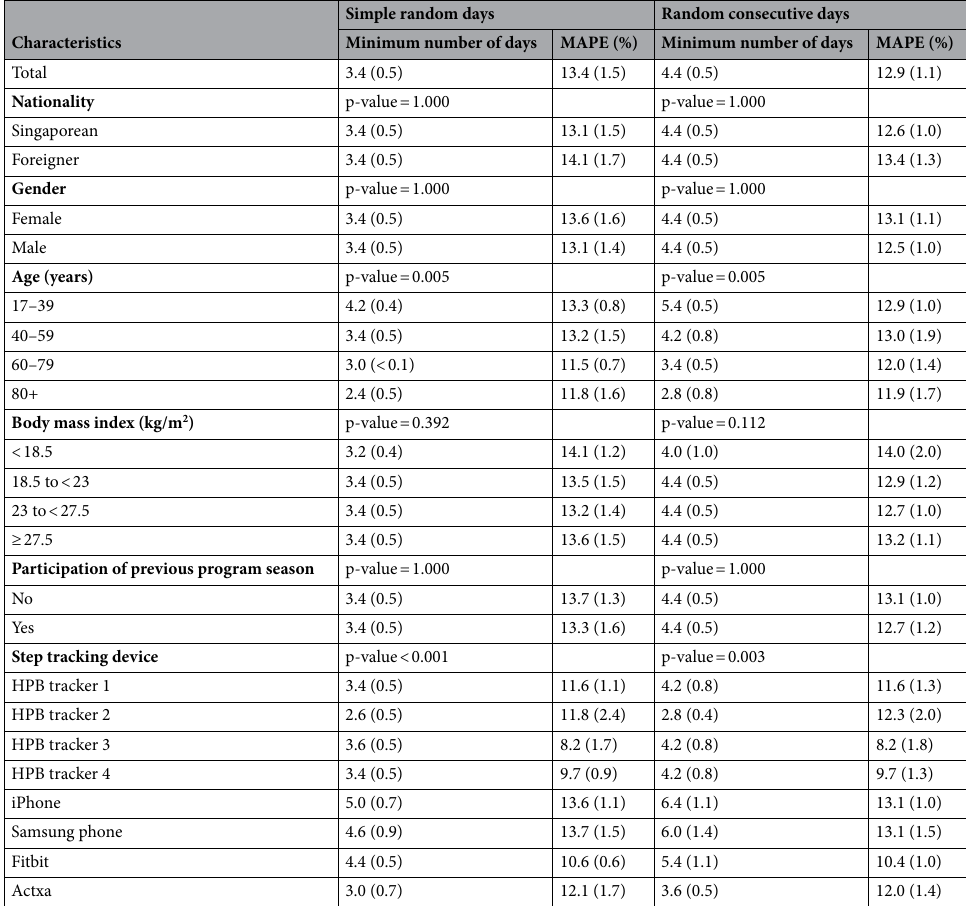
Table 3. Minimum number of days required to estimate monthly level of daily step count with ICC ≥ 80% and the corresponding MAPE (N = 112,865). Data are in mean (SD) of results over five separate months. p-values were from Friedman’s tests to compare minimum number of days required between participant groups (Supplementary Table S1). ICC intraclass correlation coefficients, MAPE mean absolute percentage errors, HPB Health Promotion